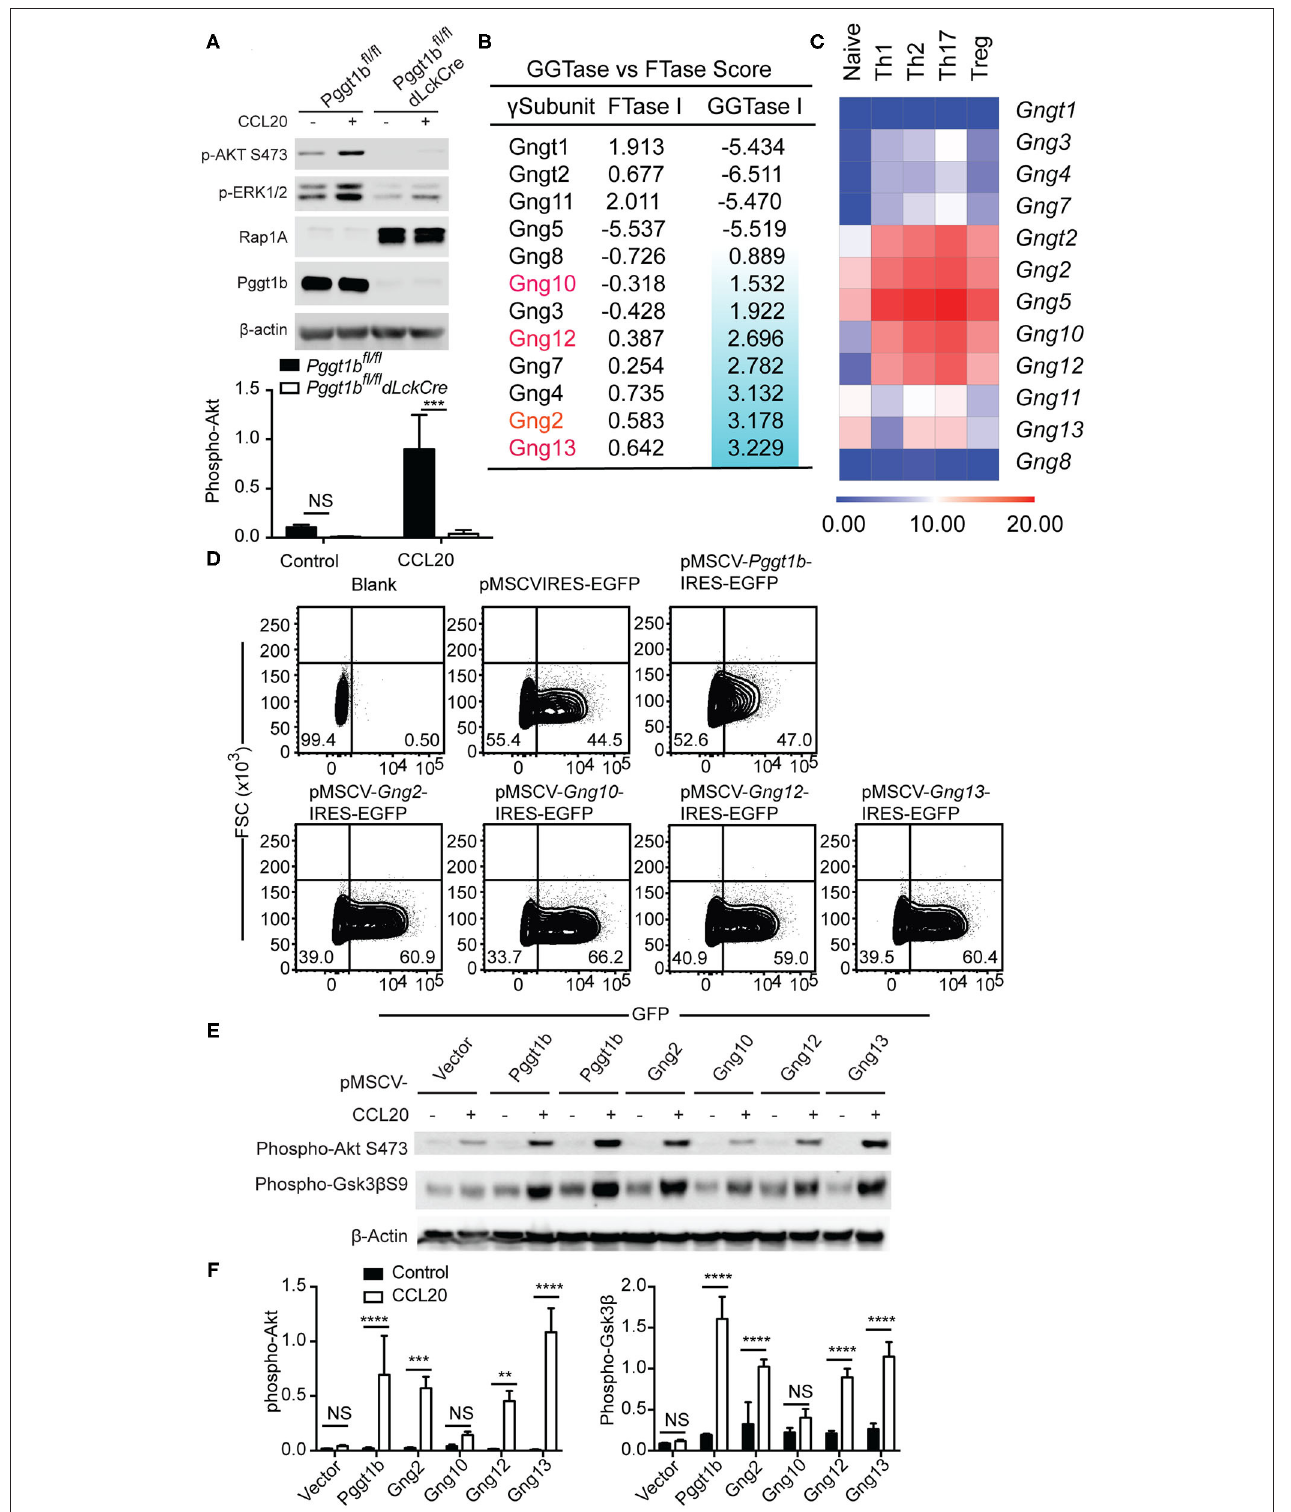
FIGURE 4 | Protein geranylgeranylation is required for heterotrimeric small G-protein mediated GPCR-proximal signaling. (A) Western blot analysis of CCL20-induced phosphorylation of Akt and Erk in Th17 cells and density of phosphor-Akt calculated using ImageJ; (B) FTase I and GGTase I scores of the 12 γ -subunits of the small heterotrimeric GTPases calculated using an algorithm described in the text; (C) Fold change of the expression of the genes encoding the 12 γ -subunits of